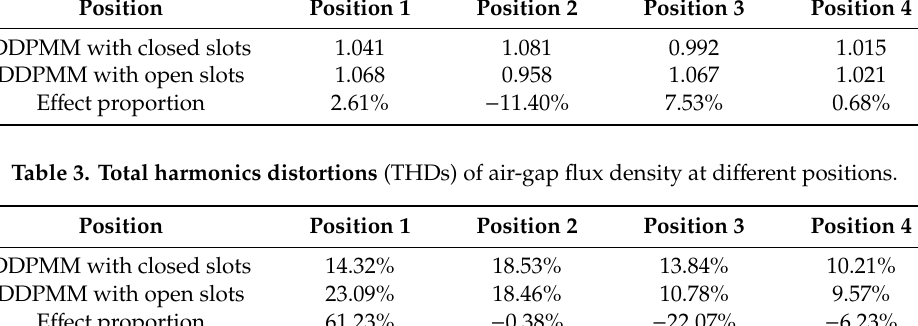
Figure 8. Magnetic field analysis at position 4: ( a ) position 4; ( b ) air-gap flux density waveforms; ( c ) harmonics of air-gap flux density.